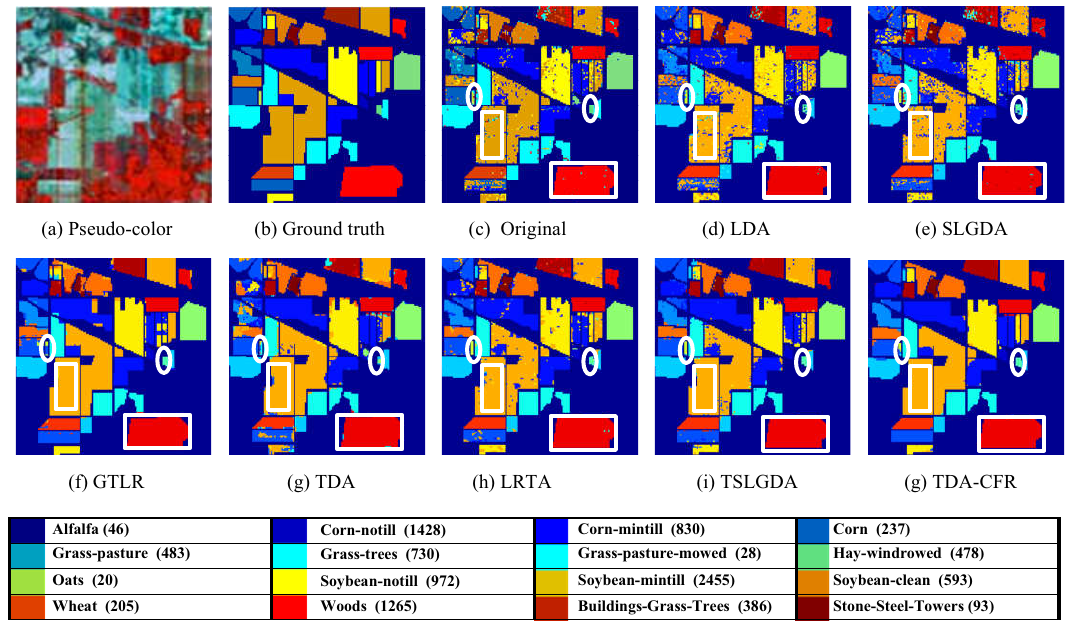
Figure 3. The classification maps on Indian Pines.